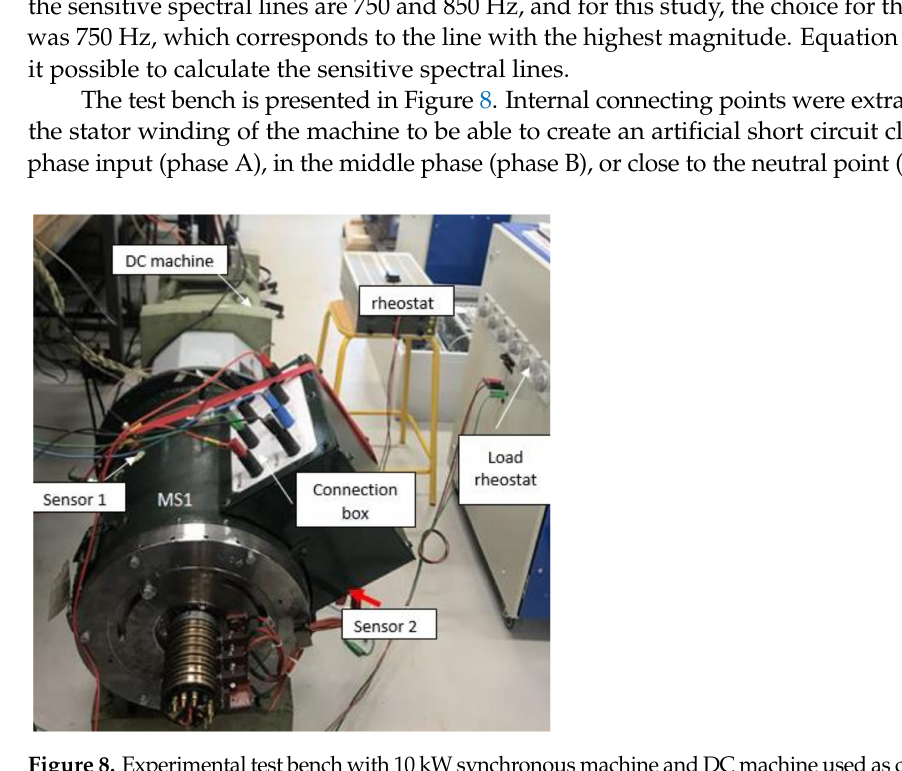
Figure 8. Experimental test bench with 10 kW synchronous machine and DC machine used as drive